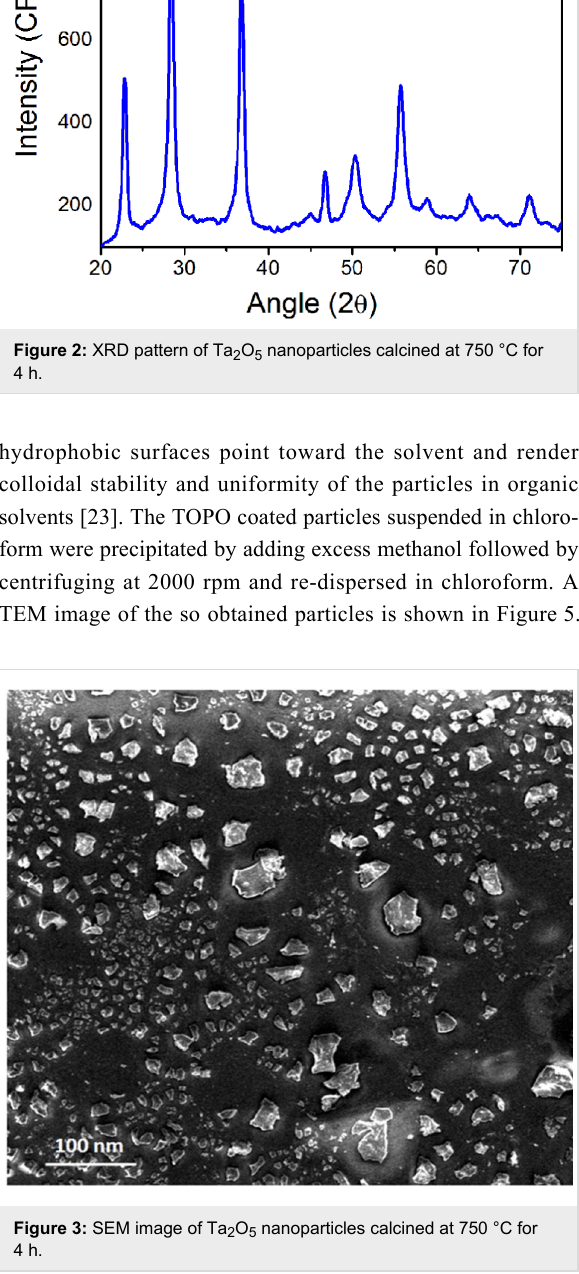
Figure 3: SEM image of Ta 2 O 5 nanoparticles calcined at 750 °C for 4 h.